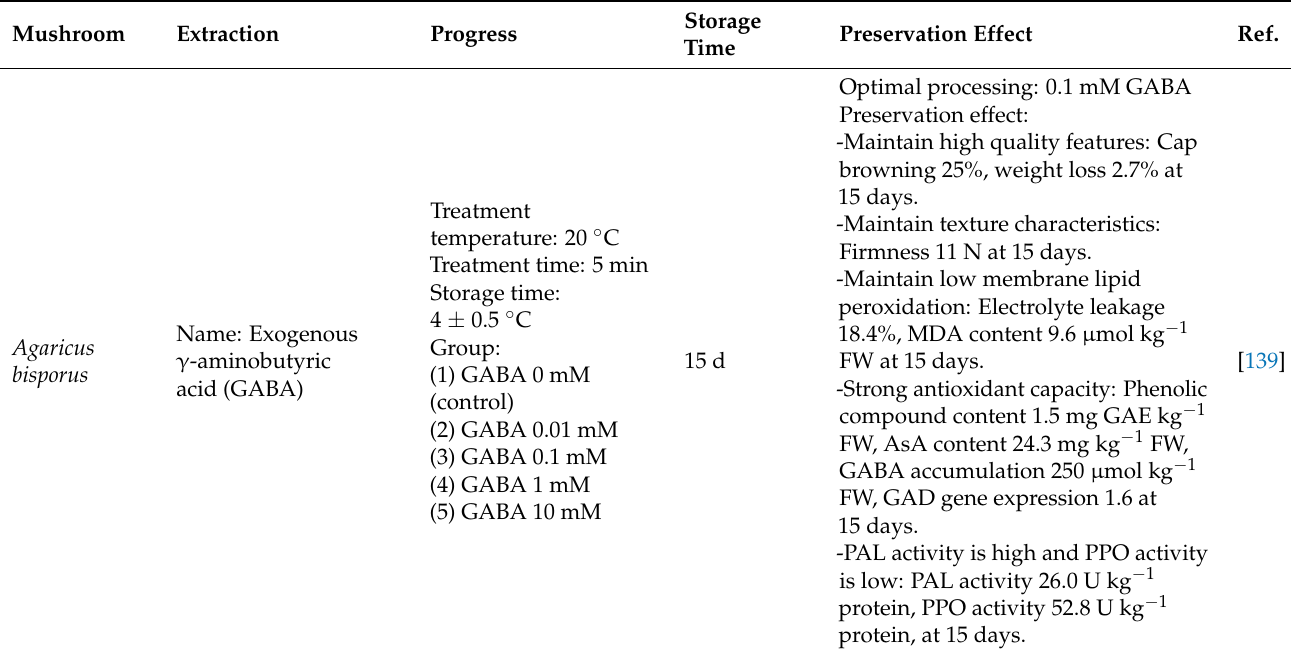
Table 2. Extracts used for the control of postharvest preservation of